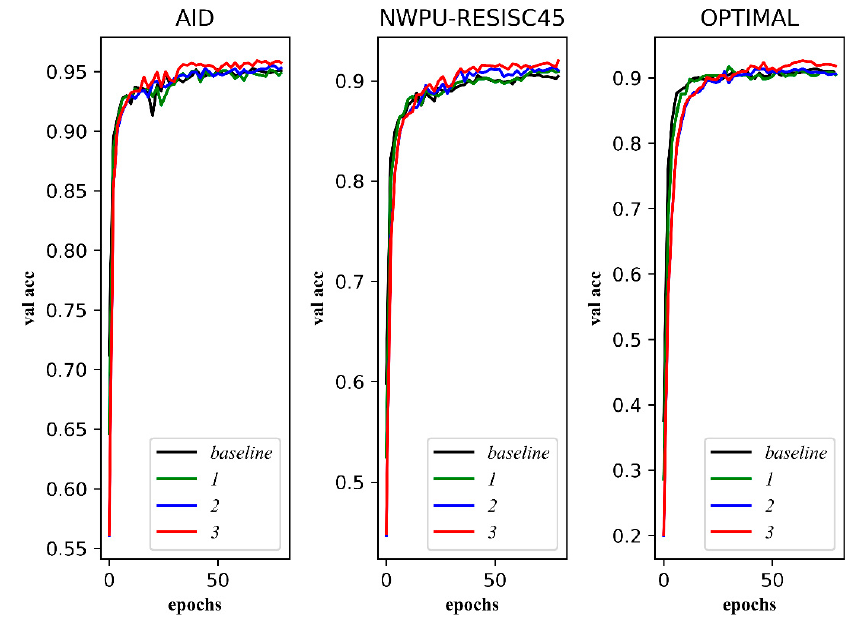
Figure 10. The transformation trend of the model’s overall accuracy of validation sets. The horizontal axis is the number of iterations, and the vertical axis is the overall accuracy of the Verification Set (val acc).